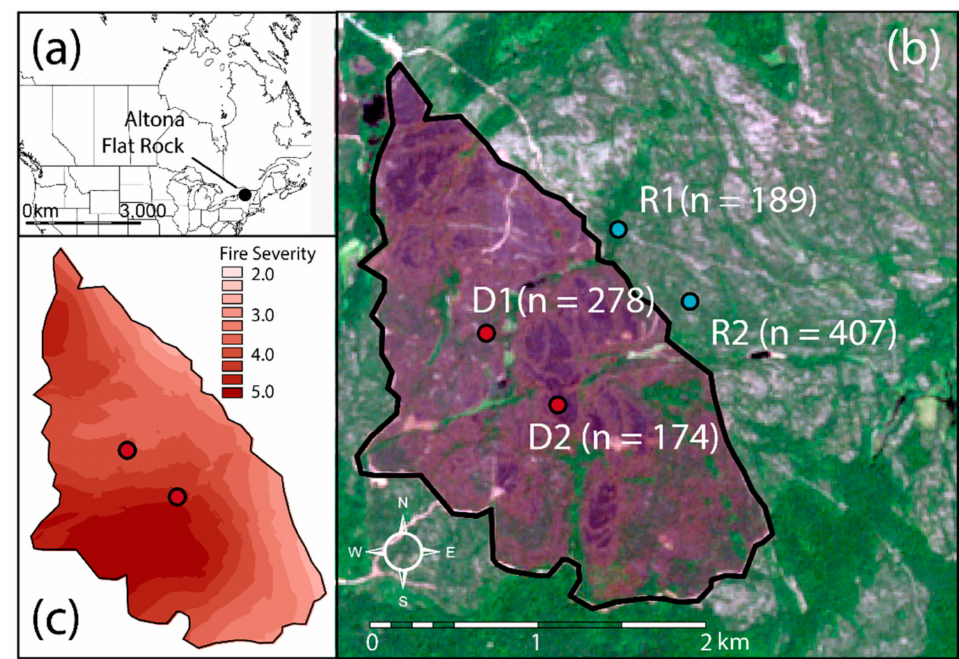
Figure 1. Map of study area showing ( a ) the regional location of the Altona Flat Rock in northern New York; ( b ) satellite image of the Altona Flat Rock centered on the 2018 fire (outlined in black). Camera locations are represented with red points within the disturbed area (sites D1 and D2) and blue points at the reference sites, located 200 m beyond the fire perimeter (sites R1 and R2). Total number of wildlife occurrences over the study duration is given in parentheses for each site; and ( c ) kriged surface [34] of fire severity based on a five-point scale, with 1 being unburned and 5 severely burned [32]. Kriging is interpolated from a network of 40 plots arrayed across the disturbed